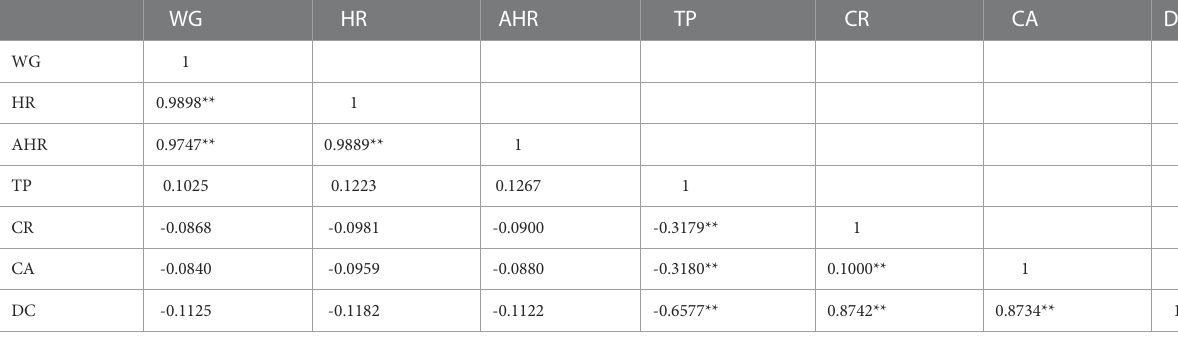
TABLE 2 Pearson correlation matrix of rice quality traits measured in a F 2 population derived from the cross between Koshihikari and Nona Bokra rice varieties. WG HR AHR TP CR CA DC